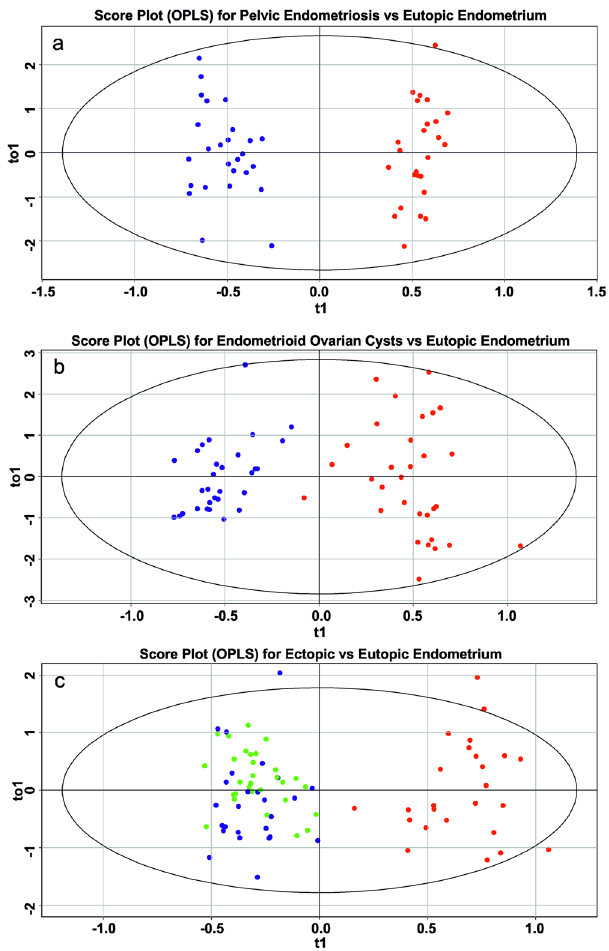
endometrium; ( c ) ectopic vs eutopic